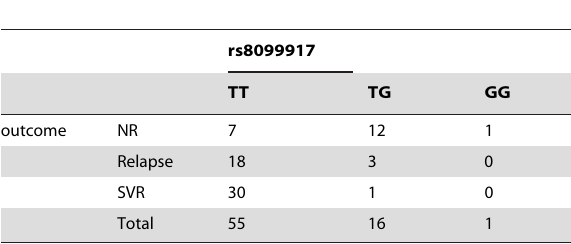
Table 6. Result of the IL28B polymorphism